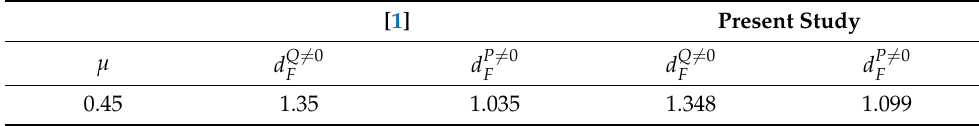
and d P (cid:54) = 0 with the results in F F